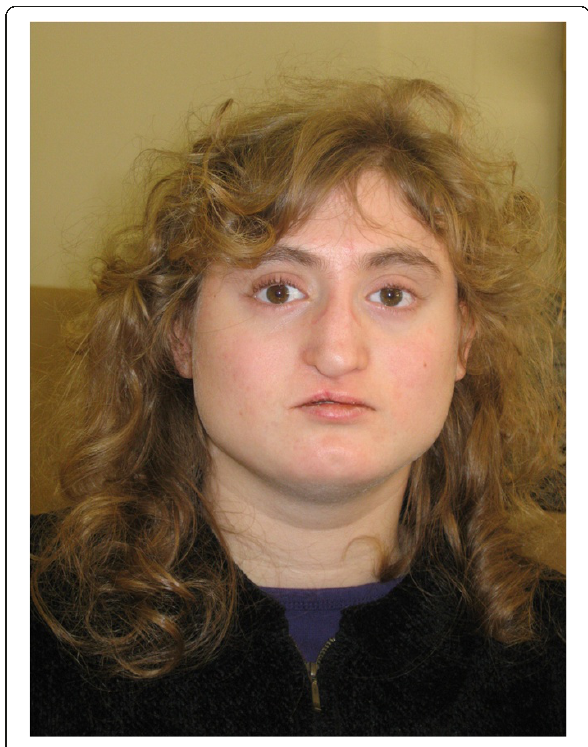
Figure 3 Facial appearance of Patient VC901 with atypical 22q11.2 deletion. Note the broad square face, hypotelorism, narrow nasal base and broad nasal bridge, overhanging nasal tip, deviated nasal tip (state post cleft lip repair), short philtrum, narrow mouth, chin dimple and broad neck.